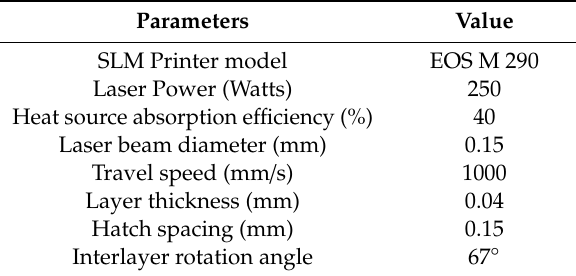
Table 1. Process simulation parameters.